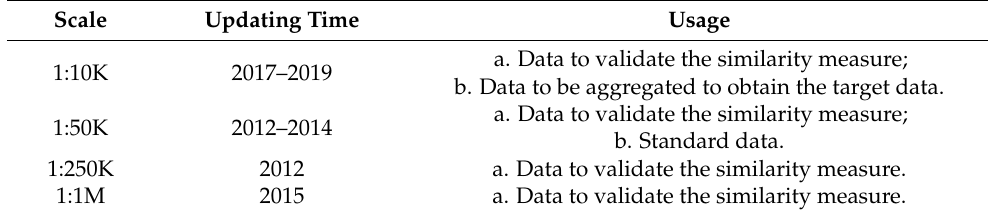
Table 1. Experiment